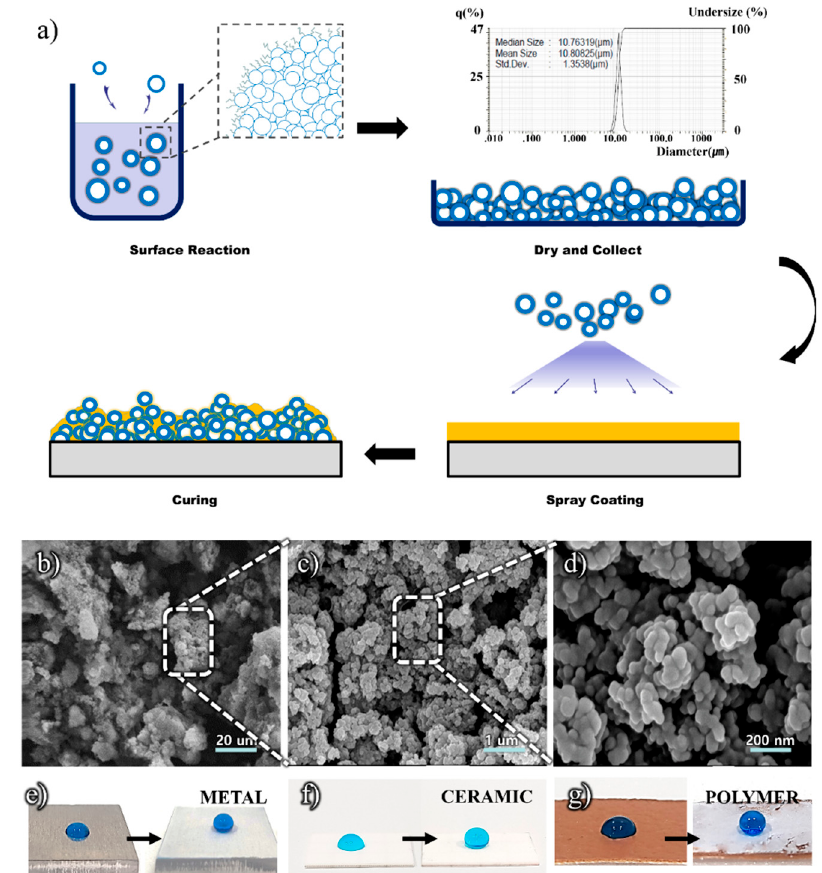
Figure 1. ( a ) Schematic for the evolution of rough surface using the spray-coating technique, ( b – d ) Surface morphology of the superhydrophobic surface structure at different magnifications, ( e – g ) Digital images of water droplets on the various superhydrophobic